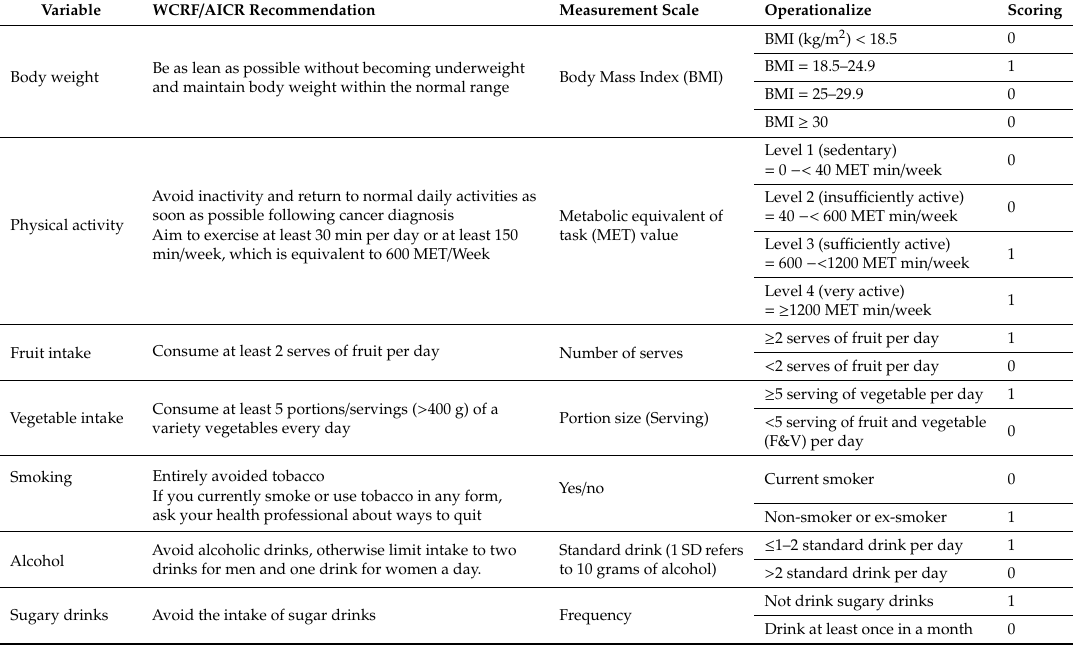
Table 1. WCRF / AICR lifestyle recommendations for cancer survivors: operationalizing and scoring recommendations in the present